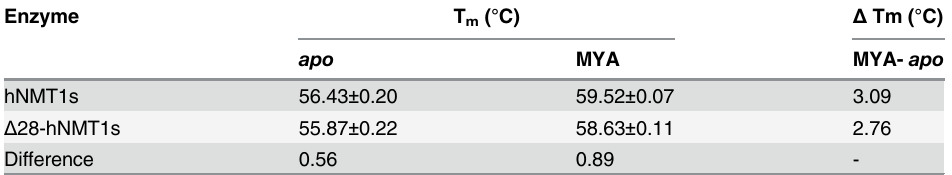
The values depicted are from the curve fi tting of the fraction unfolded (F U ) as a function of temperature directly to the Boltzmann equation, described by Eq 3 under “ Materials and methods ”